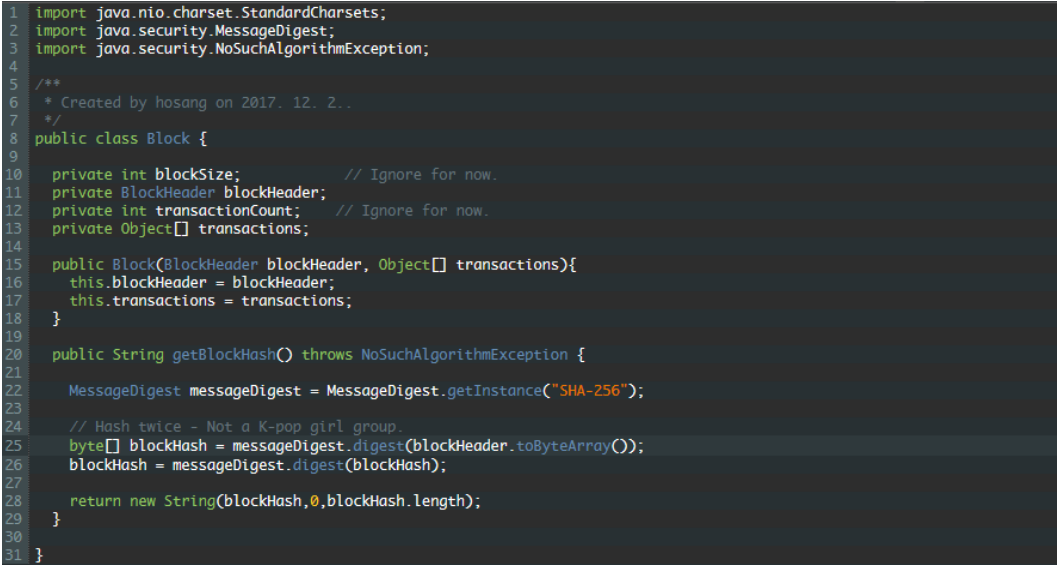
Figure 13. Block hash calculation.